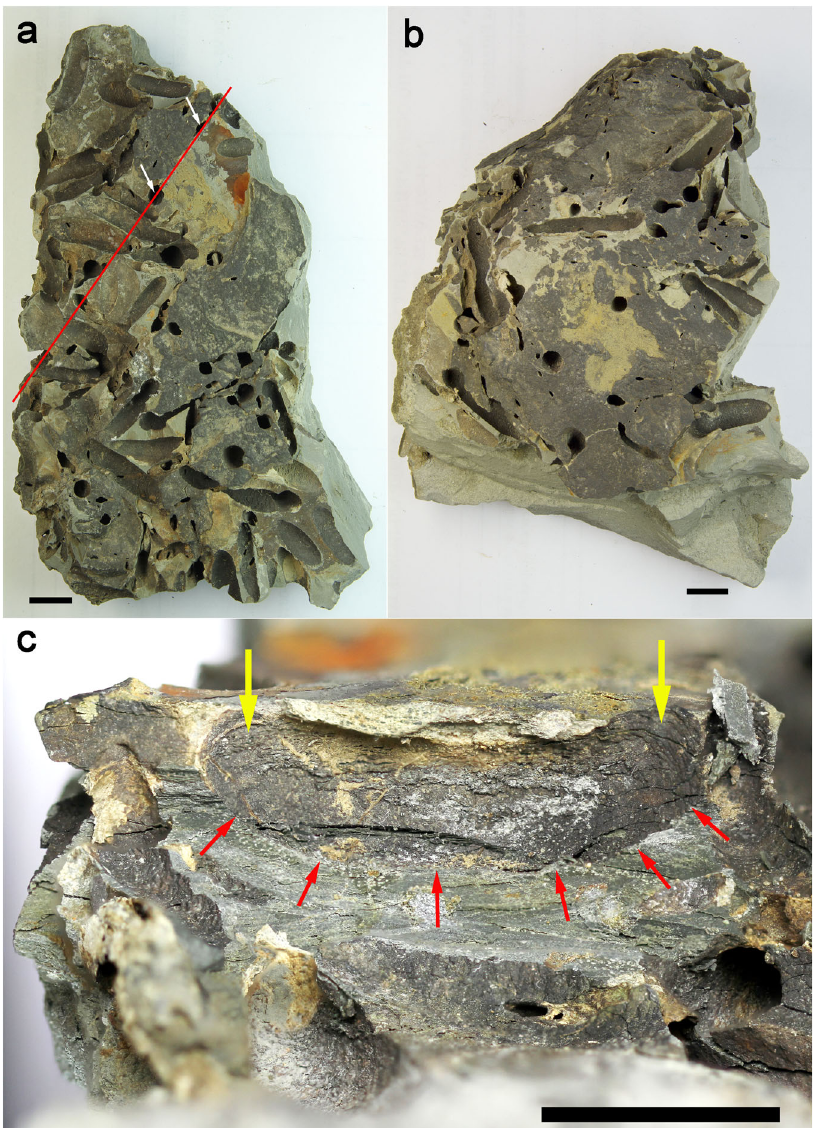
Fig. 4 Traces of the rock-boring may fl y species Languidipes lithophagus sp. nov. in siltstone rock specimens from the middle section of the Bago River, Myanmar. a Siltstone rock specimen RMBH BA-0076 with may fl y traces (plan view). The red line reveals the longitudinal section through the boring, illustrated in Fig. 4c. The white arrows show apertures of this boring. b Siltstone rock specimen RMBH BA-0077 with may fl y traces (plan view). c Longitudinal section through a boring (lateral view) in the specimen RMBH BA-0076. The yellow arrows show the apertures. The red arrows show the concave bottom outline. Scale bars = 10 mm. (Photos: Artyom A.